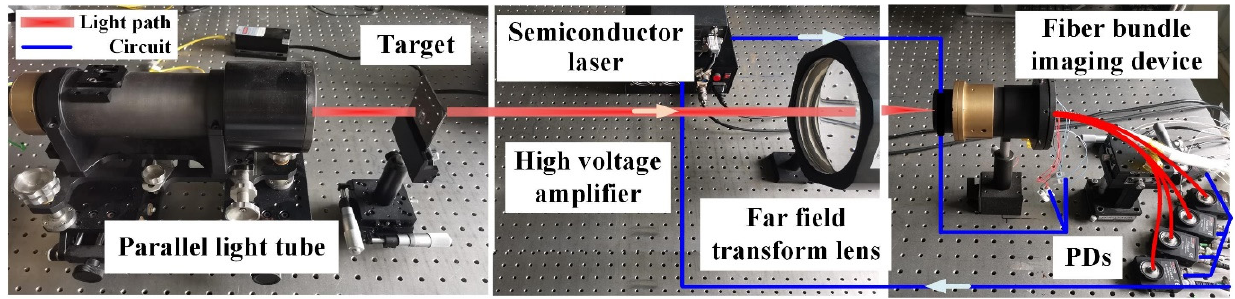
Figure 4. Photos of fiber bundle-based super-resolution imaging driving by micro-scanning.